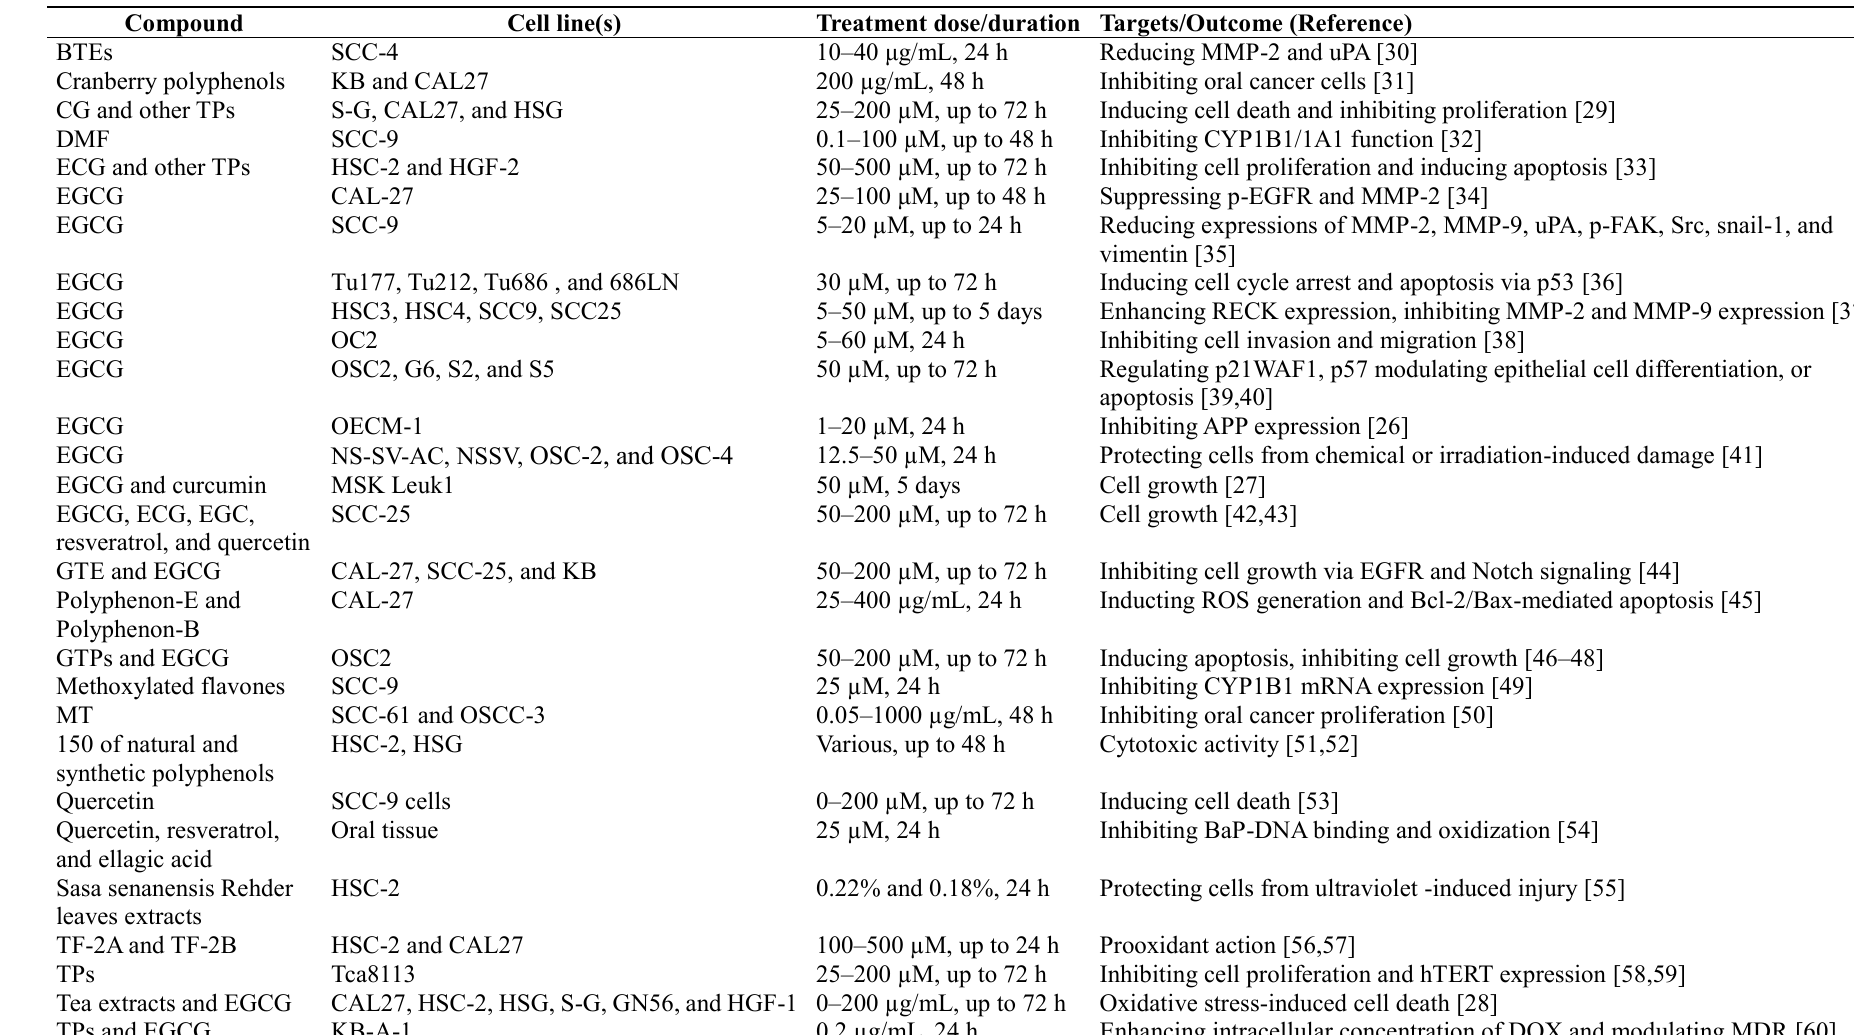
Table 1. Summary of in vitro studies of dietary polyphenols against oral